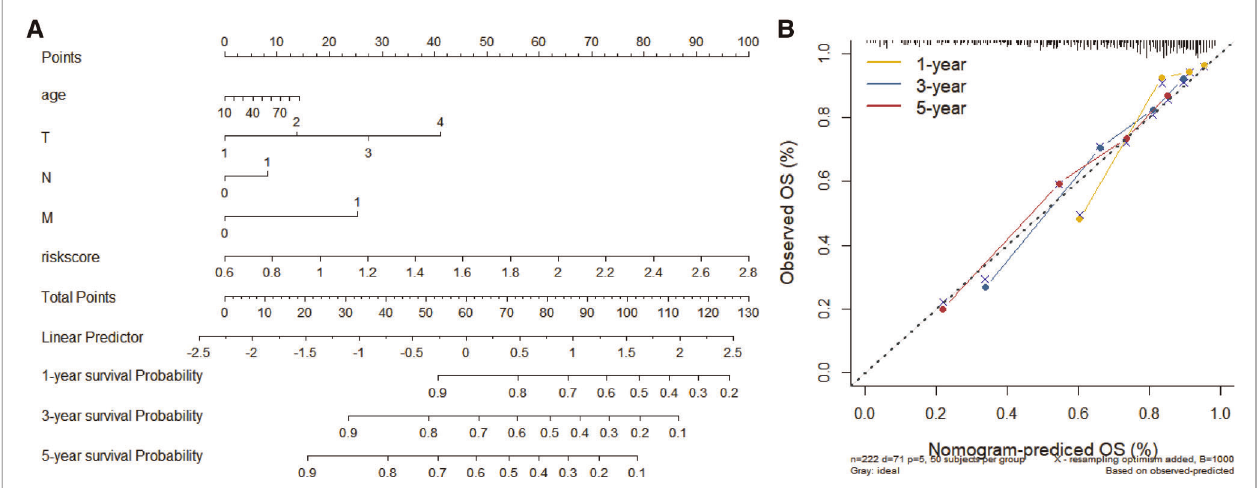
FIGURE 10 | Establishment and evaluation of Nomograms. ( A ) 1-, 3-, and 5-year Nomograms for predicting OS of HCC. ( B ) Nomogram ’ s calibration curves for predicting 1-, 3-, and 5-year OS in the TCGA cohort.